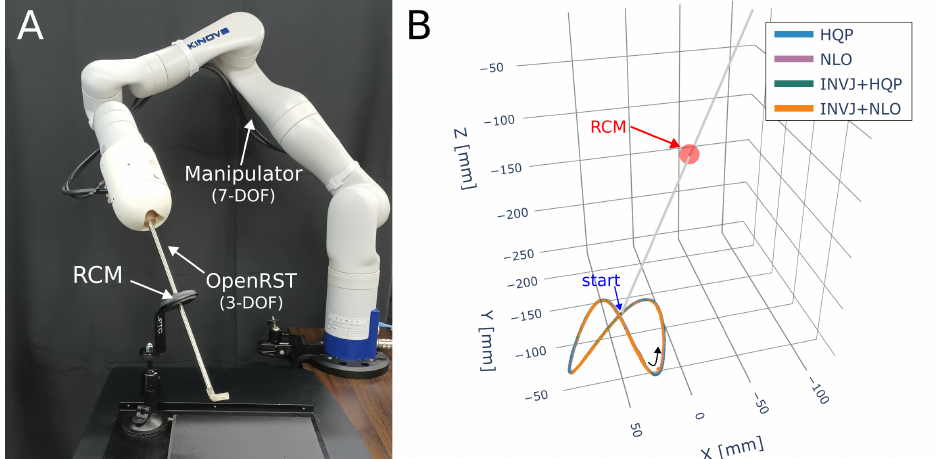
Figure 13. Endoscope positioning experiment ( A ) A 7-DOF manipulator (Gen3, Kinova) with a 3-DOF robotic surgical tool attached to the end effector. ( B ) The RCM constraint and the Lissajous trajectory followed for each IK solver.